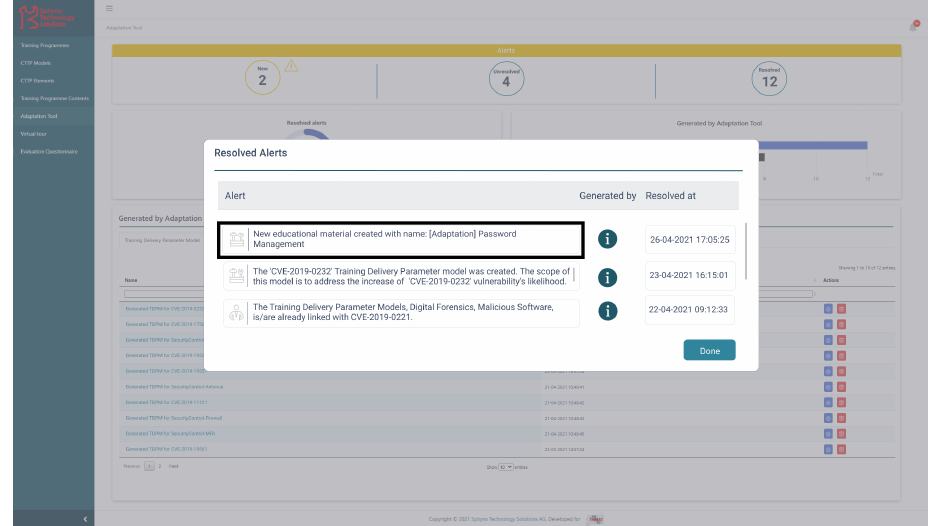
Figure 5. Adaptation based on educational material’s evaluation report